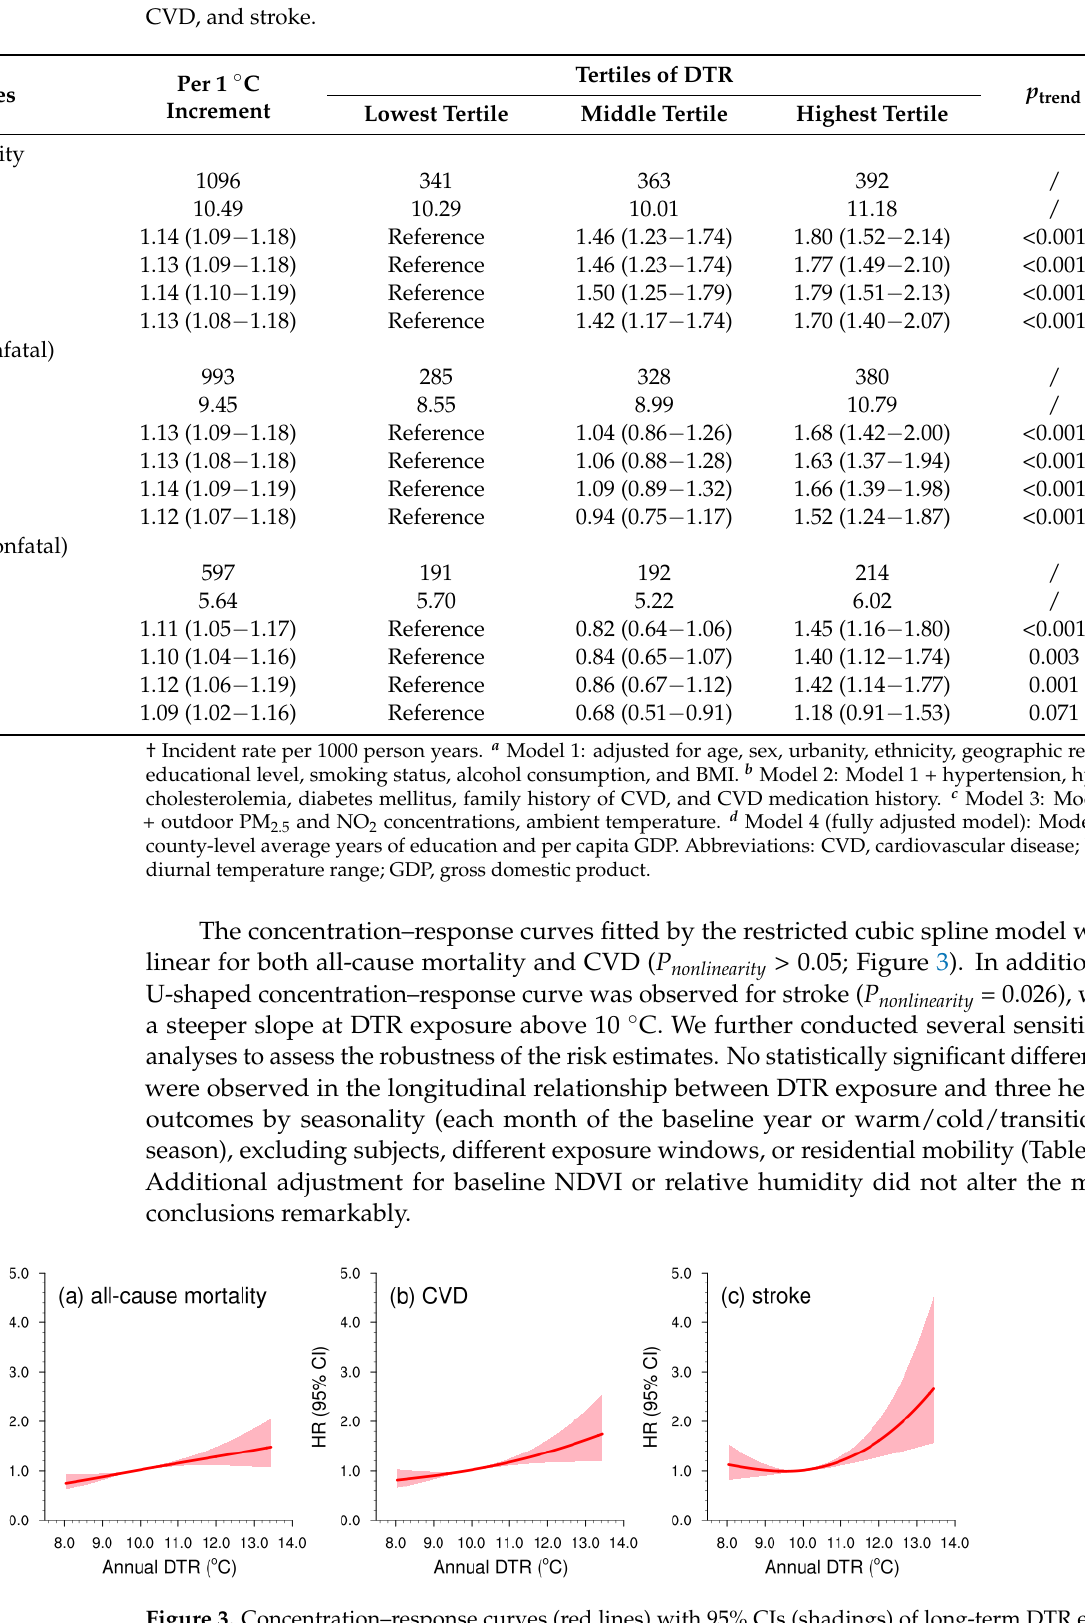
Figure 3. Concentration–response curves (red lines) with 95% CIs (shadings) of long-term DTR exposure with ( a ) all-cause mortality, ( b ) CVD, and ( c ) stroke. Abbreviations: DTR, diurnal temperature range; CVD, cardiovascular disease.